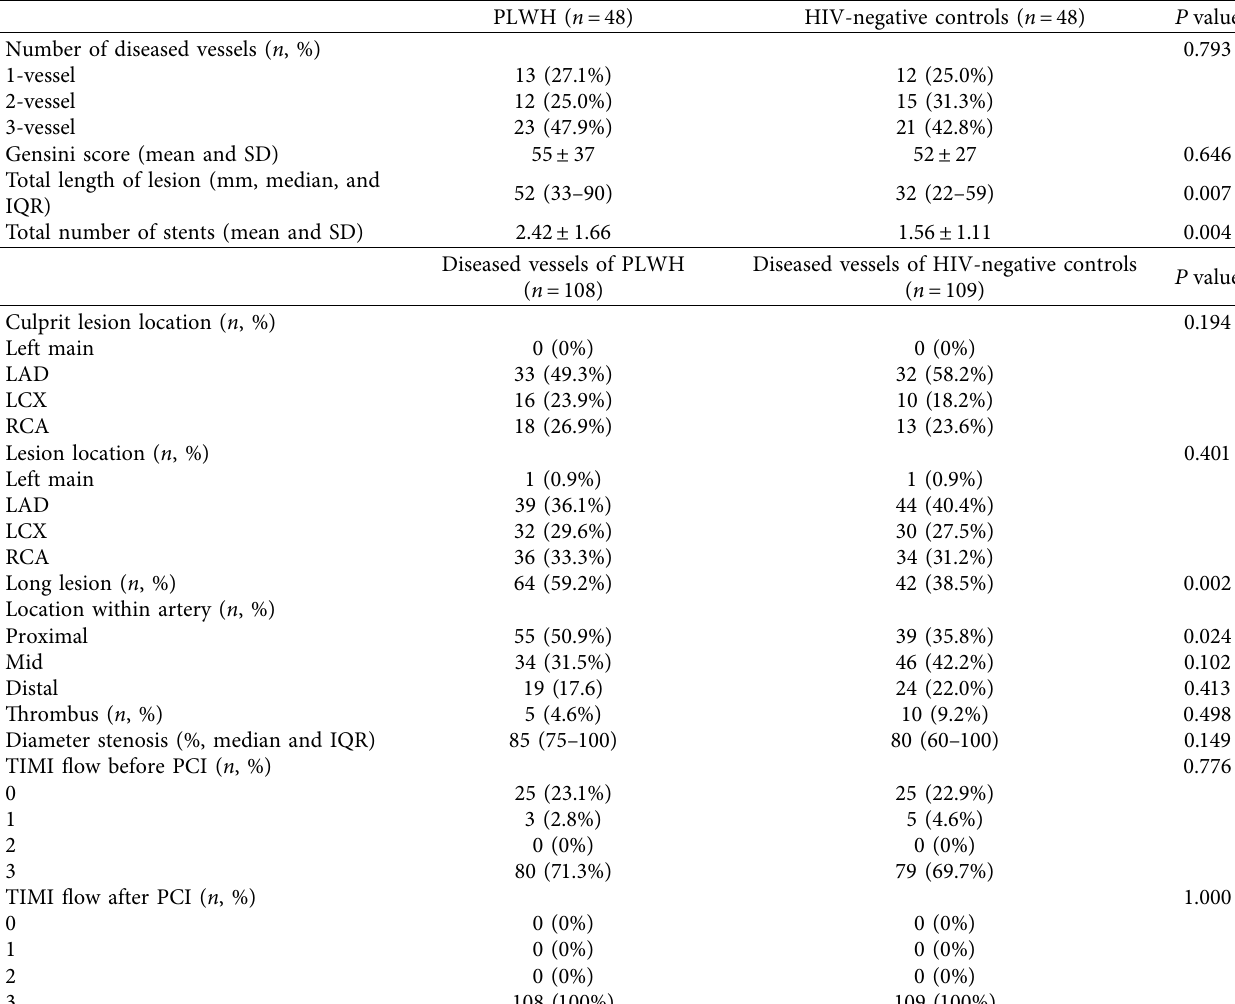
Table 3: Angiographic characteristics in PLWH and HIV-negative